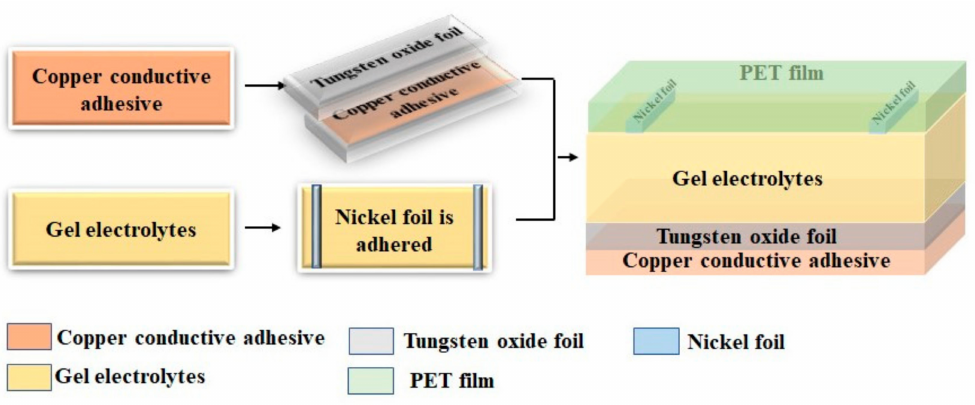
Figure 1. Assembly of